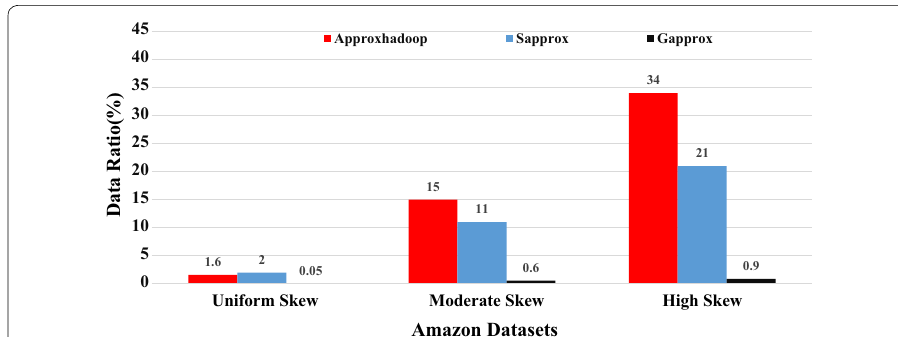
Fig. 16 Impact of data variety on the sampling overhead (Amazon datasets)